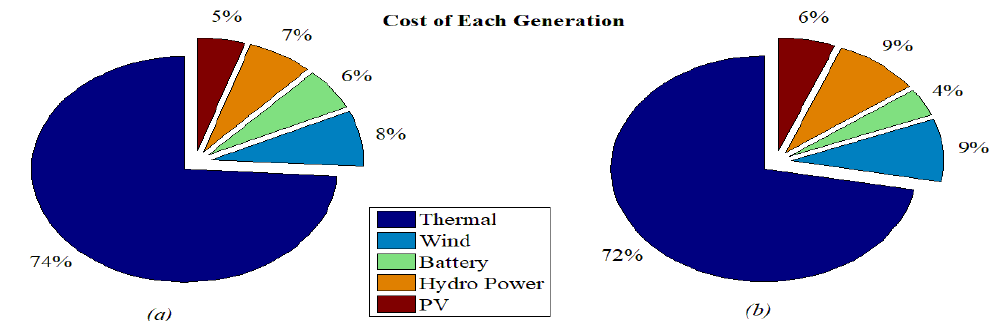
Fig. 17: Cost share of each generation in whole day (a) in [48] (b) by developed